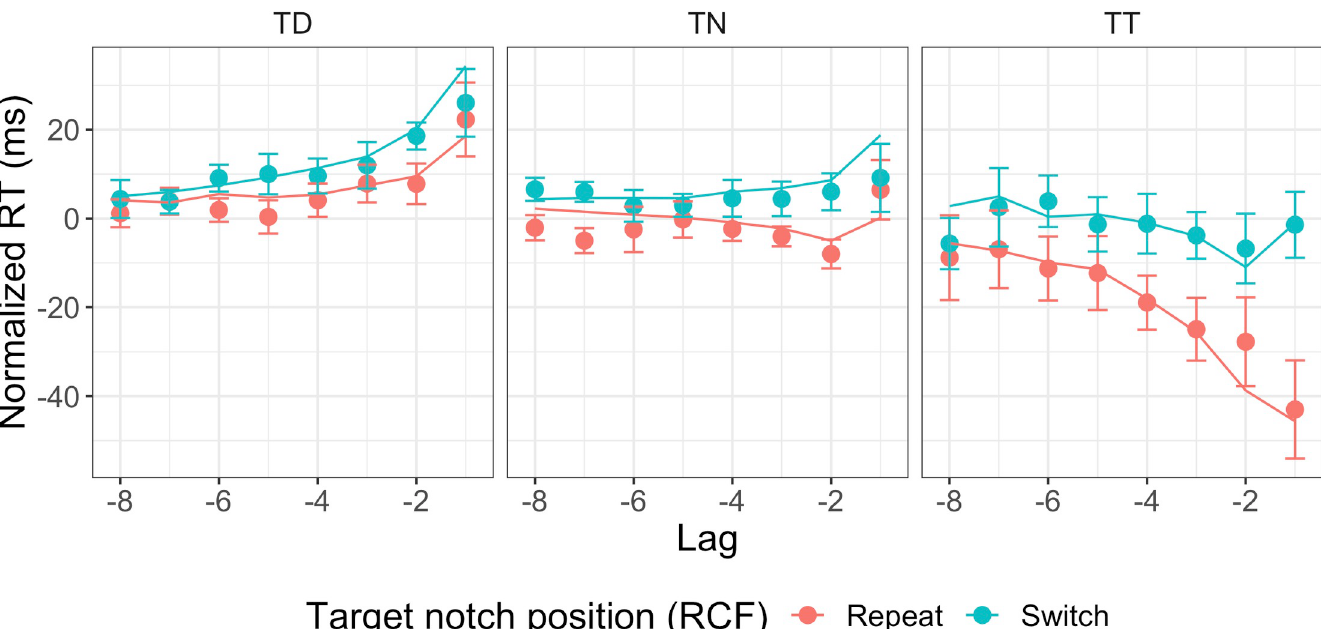
Fig 13. Temporal profile of the response feature-based inter-trial effects. Mean normalized RT for repetition vs. switch of the response defining target feature (notch on top or bottom of the diamond shape), compared to trial n-1 (lag 1), n-2 (lag 2) up to n-8 (lag 8) for the different positional inter-trial conditions, target in previous target condition (TT), target in previous distractor position (TD), target in previously neutral (unoccupied) position (TN). Normalized RTs were first averaged across the two sessions for each participant; the resulting (individual mean normalized) RTs were then used to compute the overall means and confidence intervals, across participants. Filled circles show the behavioral data, while lines show model predictions. Error bars represent 95% confidence intervals. RCF: response-critical feature.